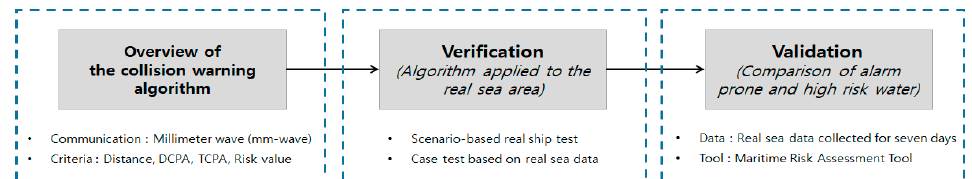
Figure 1. Flowchart of the study.